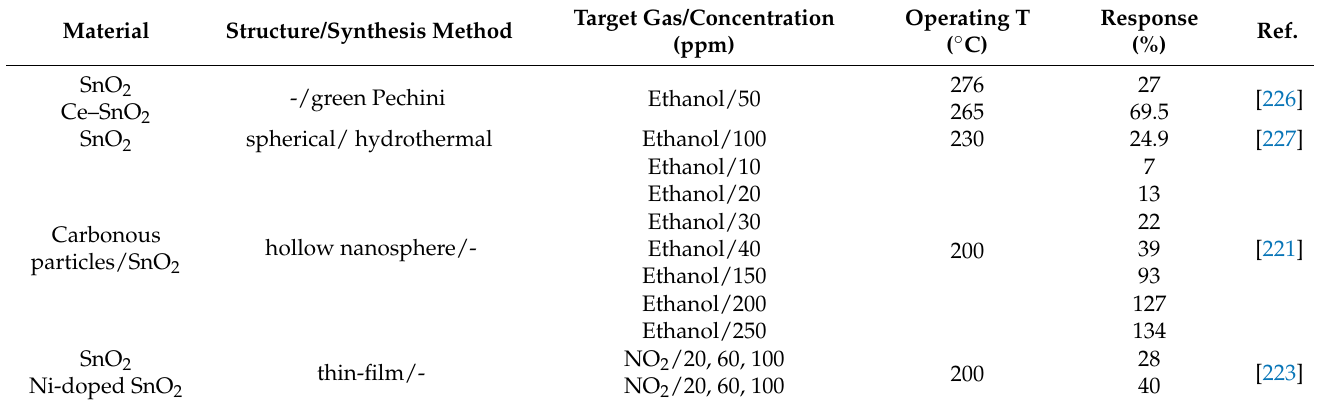
Table 10. A comparison of gas sensing characteristics of SnO 2 -based gas